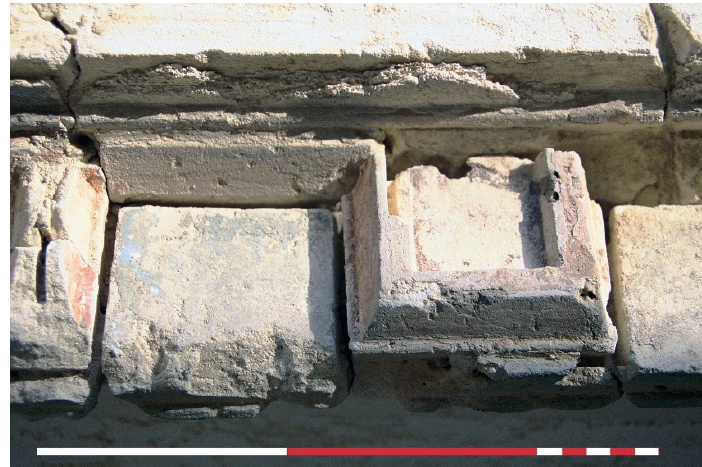
Figure 20. Fragment of polychrome cornice crowning an aedicula from the oikos of house H10 (photo Rafał Czerner).